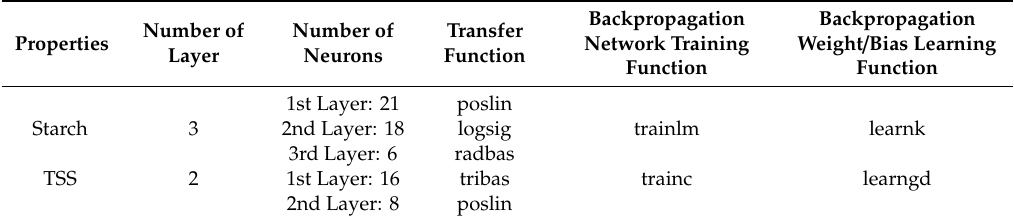
Table 2. Optimal structure of ANN hidden layers adjusted by the biogeography-based optimization algorithm (BBO) algorithm to predict the Fuji apple properties.